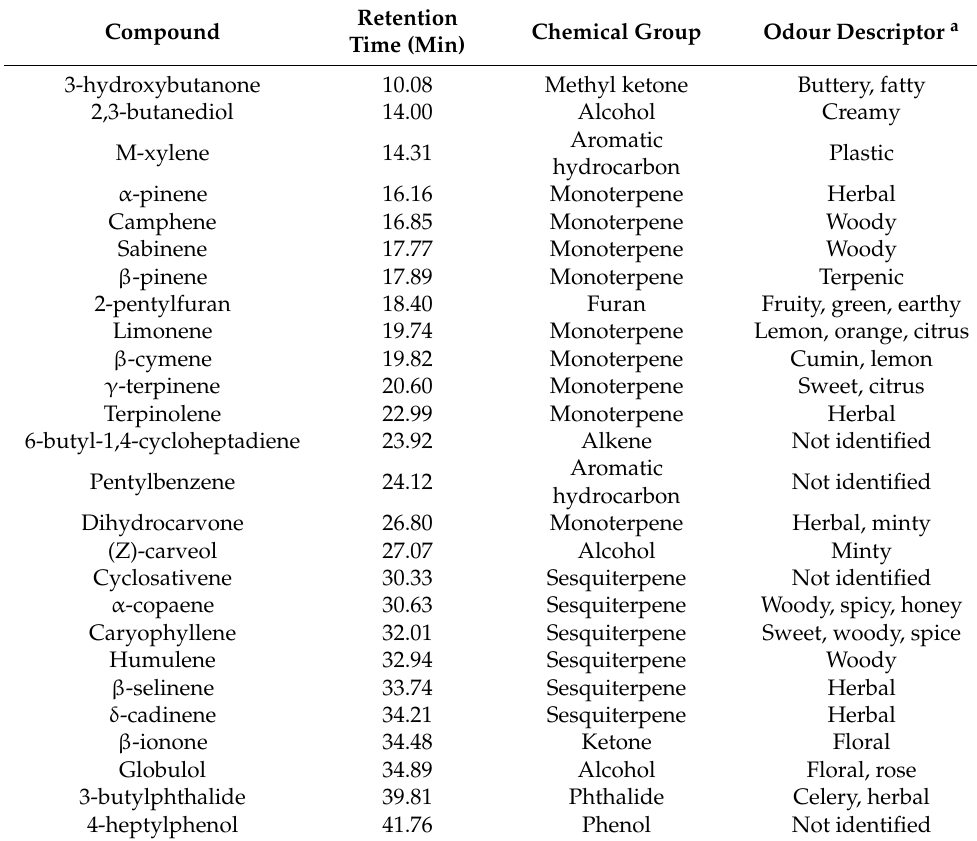
Table 2. Volatile compounds identification, retention times and sensory descriptors obtained by headspace solid phase microextraction–gas chromatography–mass spectrometry (HS-SPME–GC–MS) in stalk and root celery